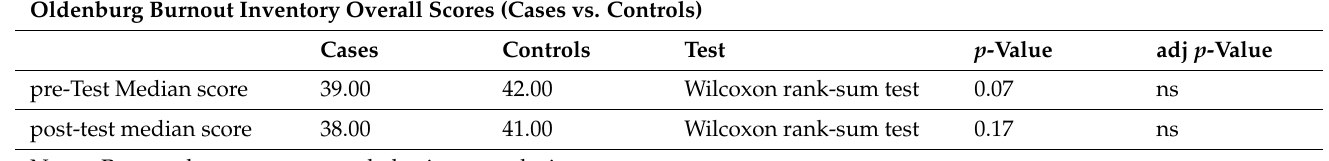
Table 2. Pre- and post-test analysis of Oldenburg Burnout Inventory and Mini-Z